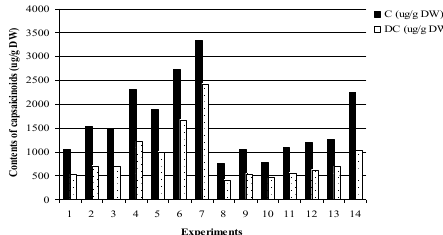
Figure 1. Contents of capsaicinoids obtained from various conditions of ASE using MeOH as a solvent.